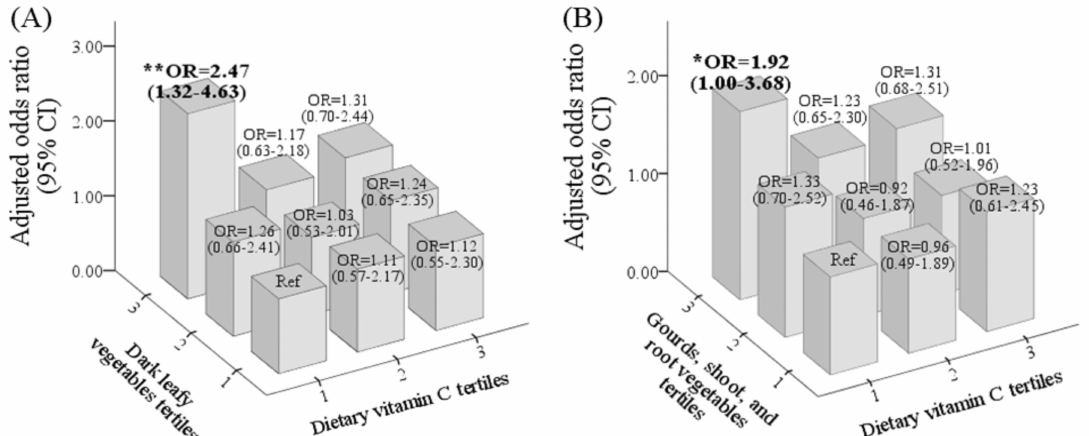
Figure 2. Odd ratio (OR) and 95% confidence interval (CI) of iron-deficiency anemia (IDA) for the interactive effect of vitamin C and dark leafy vegetables ( A ) and gourds/shoots/root vegetables ( B ) after adjusting for age, pre-pregnancy body-mass index, region, parity, total supplement use (%), and trimester. p value/ p for trend as * p ≤ 0.05, ** p ≤